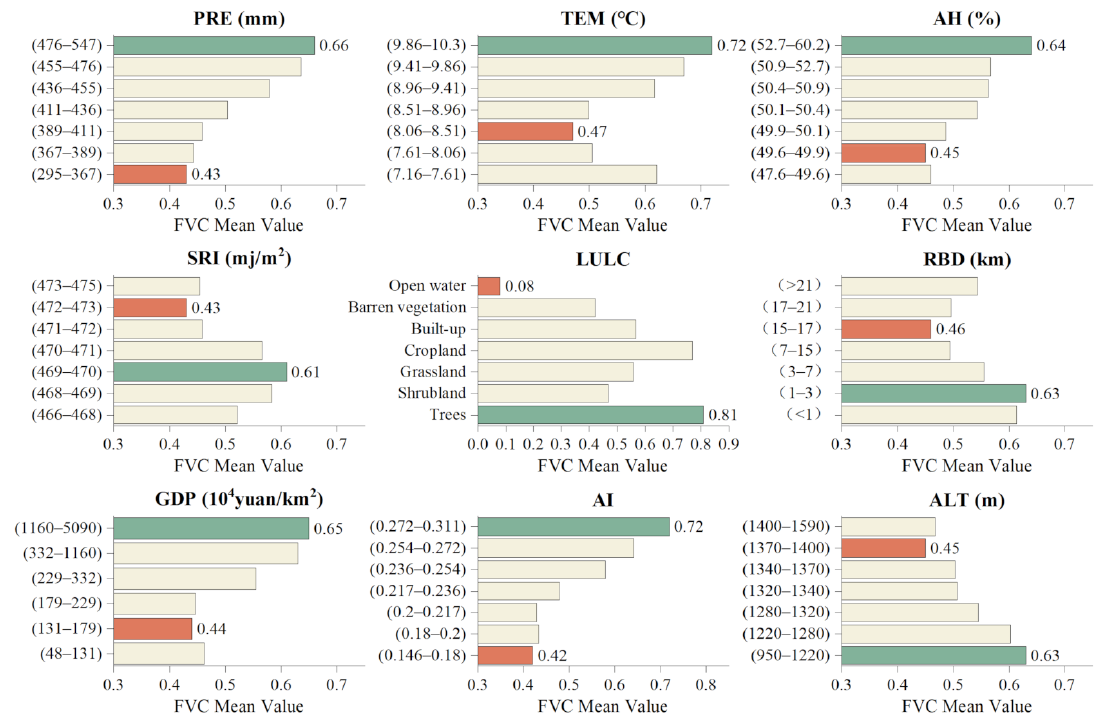
Figure 11. Risk detector results for each